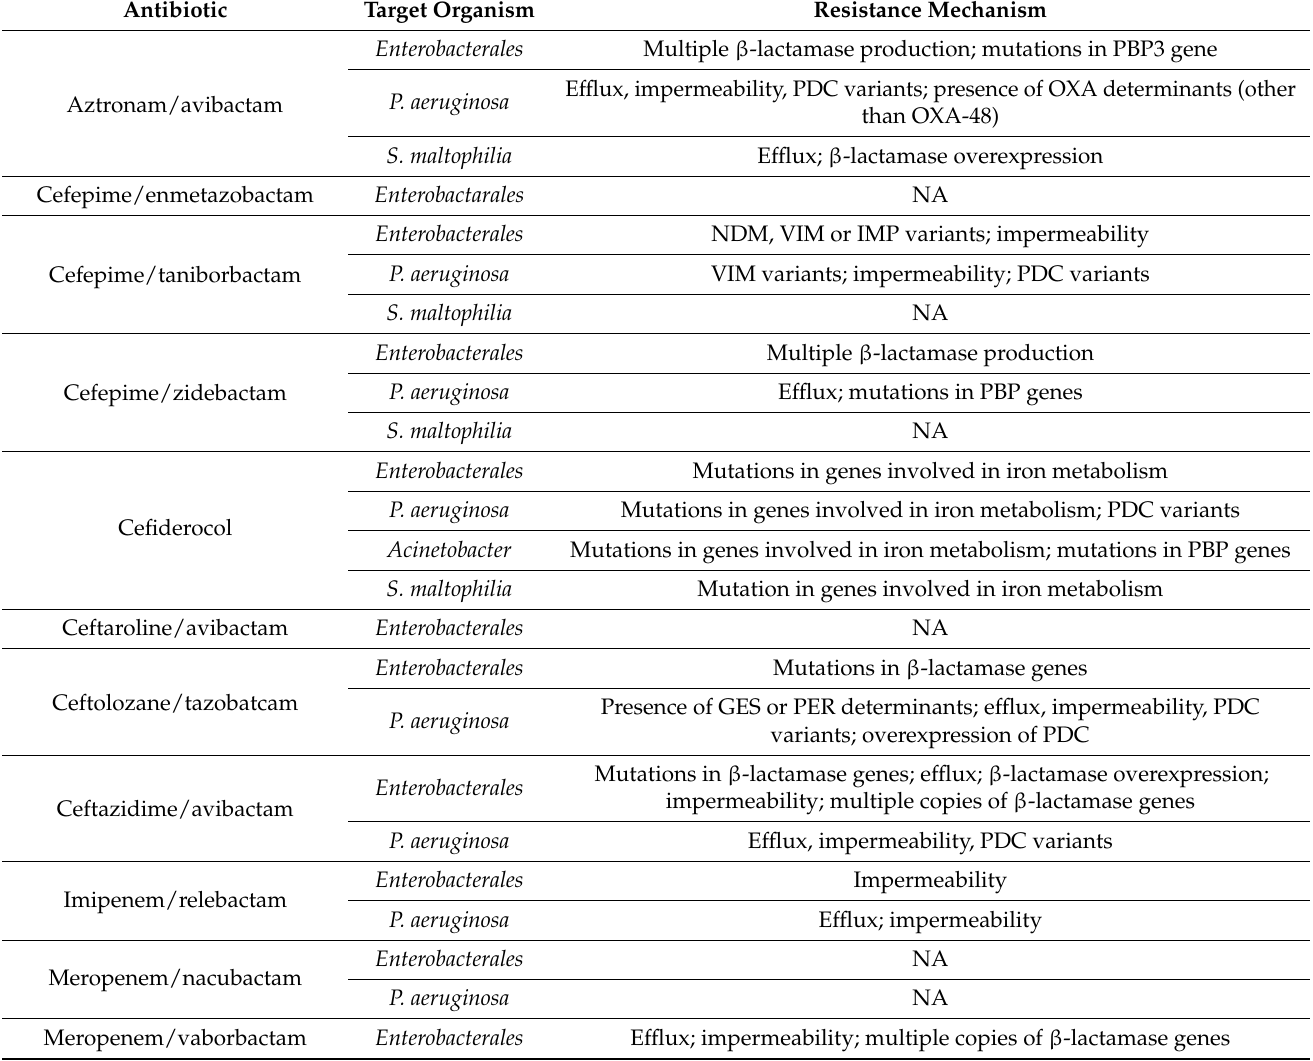
Table 6. Resistance mechanisms in target